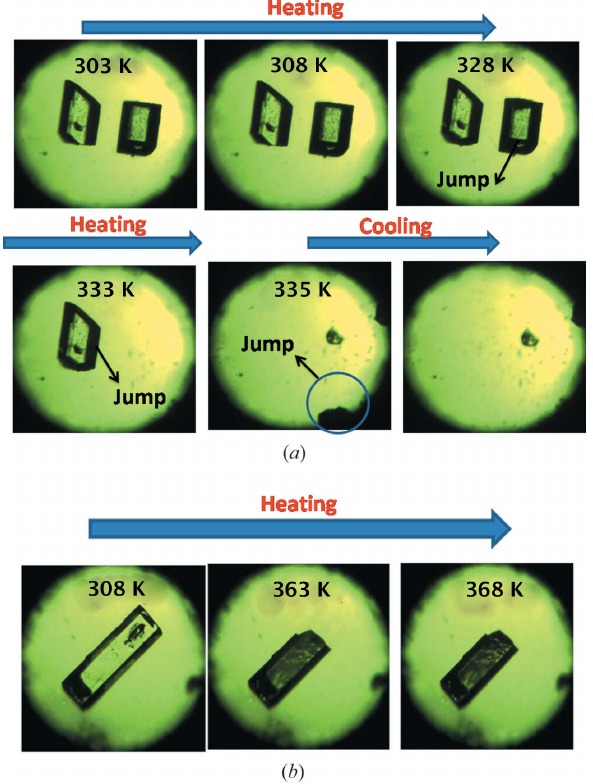
Figure 1 ( a ) HSM images of Compound-A Form I crystals during heating. ( b ) HSM images of Compound-C Form I crystals, and separation of debris during